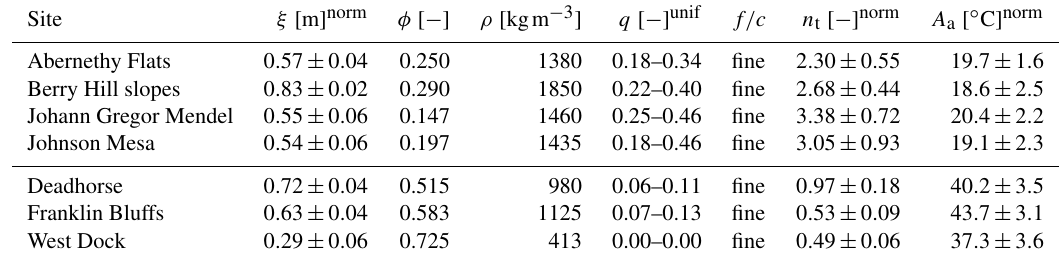
Table C1. Variables used to model air temperature characteristics at the James Ross Island (upper section) and Alaskan Arctic (lower section) validation sites. Note that the superscripts norm and unif indicate normal and uniform distributions describing the respective